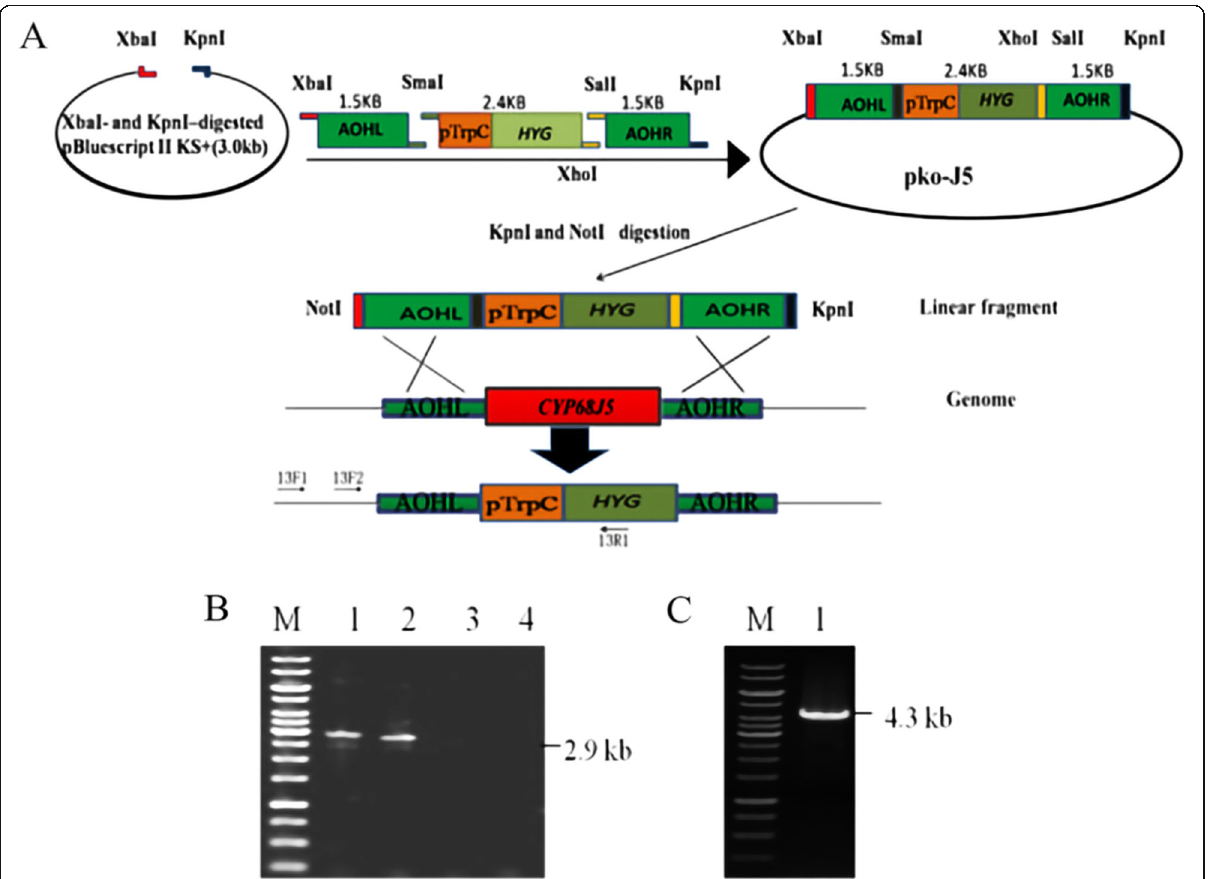
Fig. 3 Disruption of CYP68J5 and mutant verification. a Diagram of the strategy for CYP68J5 mutation and mutant verification. b Verification of the cyp68j5 mutant by PCR analysis. PCR products were separated on a 0.8% agarose gel. Lanes 1 and 2, with primers 13F1 and 13R1, 13F2 and 13R1, respectively, using the cyp68j5 mutant genomic DNA as a template and lanes 3 and 4, with primers 13F1 and 13R1, 13F2 and 13R1, respectively, using the recipient strain TCCC41060 genomic DNA as a template, which serves as a control. c PCR amplification of the full ORF of the cyp68j5 mutant locus with primers X and